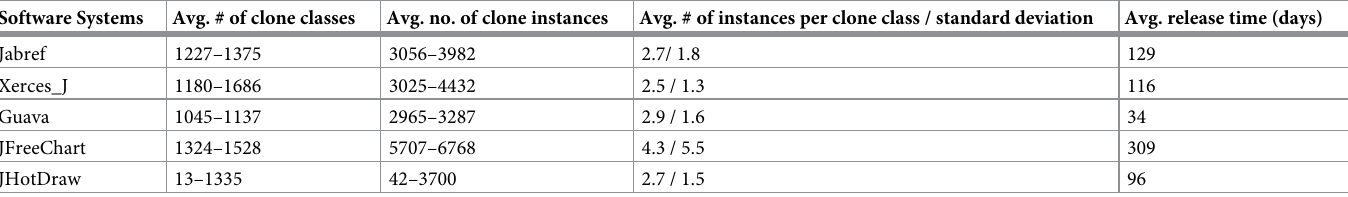
Table 2. Statistics of clone refactorings in five java systems. Software